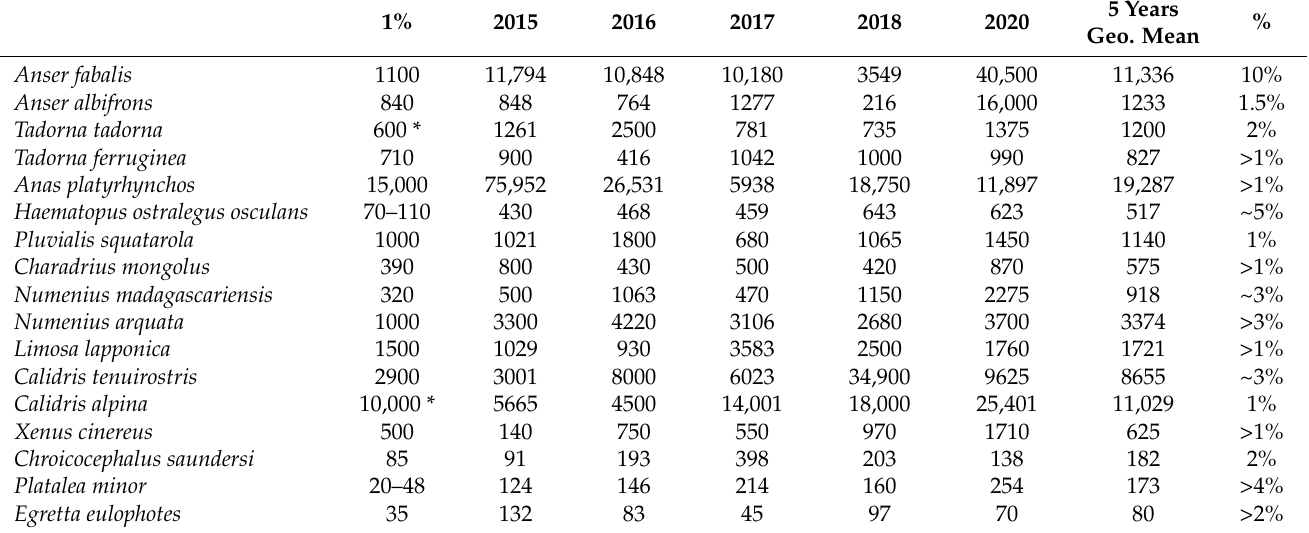
Table 7. Waterbird species regularly supported by the Hwaseong Wetlands FNS in concentrations of 1% or more of a population based on the five-year geometric mean (5 years Geo. mean) of counts made in 2015–2018 and in 2020. Here % stands for the percentage of the total of the relevant population of that species as assessed in July 2021 by Wetlands International (2021) [45]. Subsequent revision to these estimates can affect application of the appropriate 1% threshold